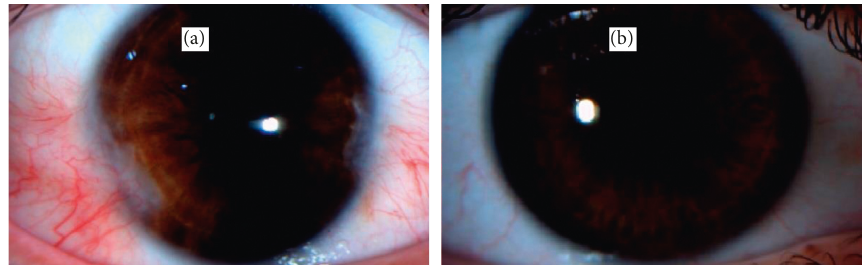
Figure 1: External photograph of case 1 of double-headed pterygia before (a) and 1 year after (b) surgery.